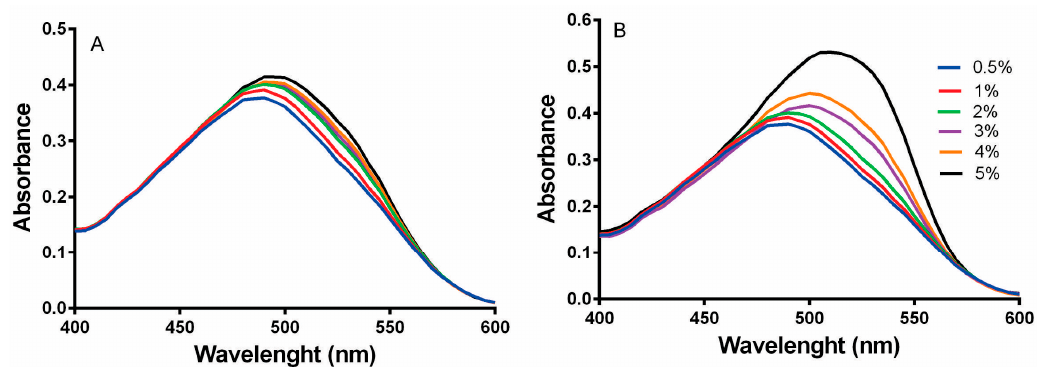
Figure 3. Congo red absorption spectra: ( A ) CR spectra for native whey protein at different concentrations (0.5–5%); ( B ) CR spectra for amyloid WPF at different concentrations after heat treatment. The absorption spectra were recorded from 400 to 600 nm.